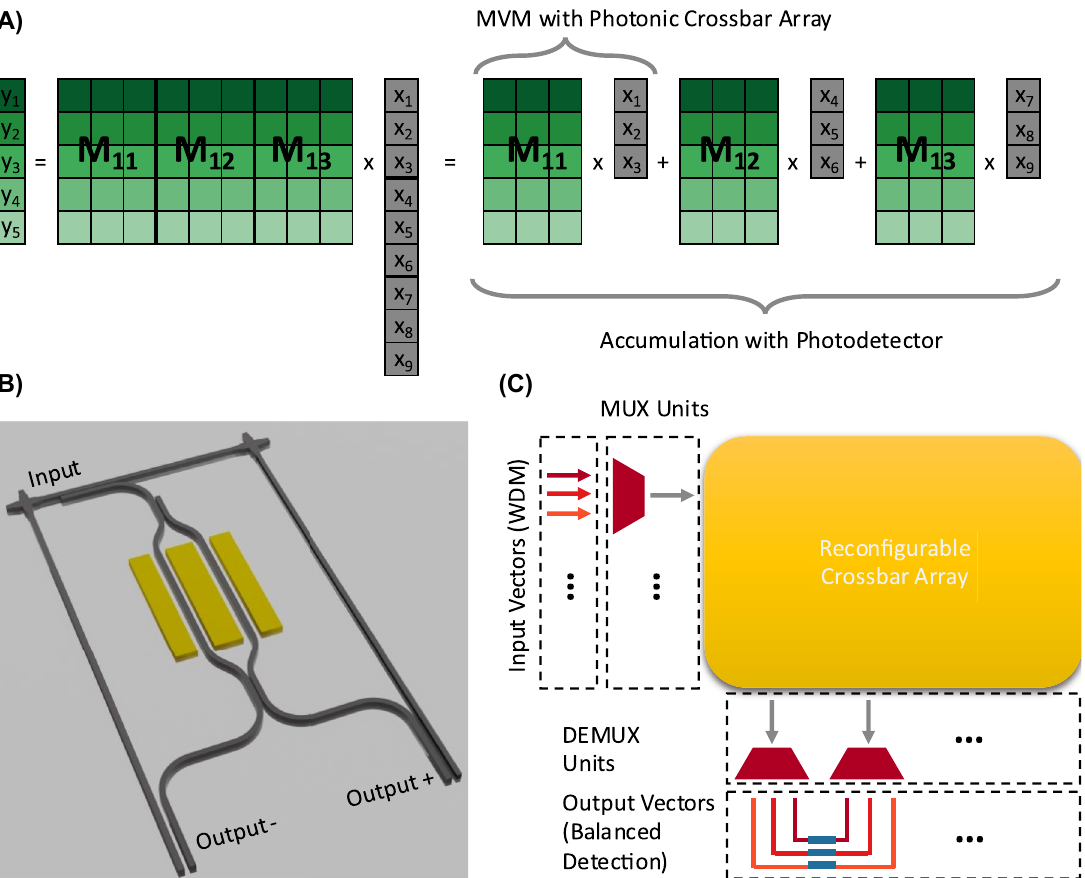
Figure 3: Large scale photonic matrix vector multiplication scheme. (A) Time multiplexed matrix vector multiplication (MVM). We decompose the large-scale matrix vector multiplication into several small MVMs which the photonic crossbar array computes. We sum the intermediate results by charge accumulation inside the photodetector. In this way, no additional electrical processing is required. (B) Concept of an active, arbitrary valued matrix cell. We design matrix cells deploying an MZM as the matrix weight. In this way, the weight can be modulated as fast as the input vector, which is crucial for this matrix architecture. Moreover, the MZM allows for lossless reference computation. (C) Sketch of the complete matrix processor. The processor computes several MVMs in parallel by encoding each vector in a different wavelength range. Before sending the vectors to the crossbar array, they are multiplexed together and afterwards demultiplexed again to obtain the individual output vectors. Finally, balanced detection is performed to obtain the correct